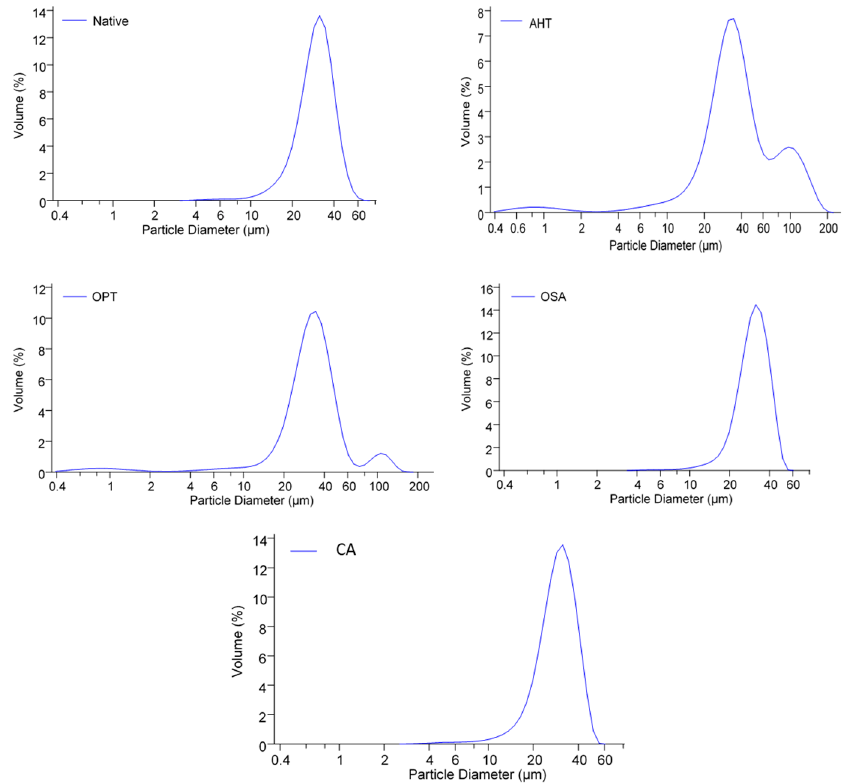
Figure 2. Particle size distribution of native and various modified sago starches. AHT = autoclave- heating treatment, OPT = osmotic-pressure treatment, OSA = octenyl-succinic anhydride, CA = citric acid cross-linking.